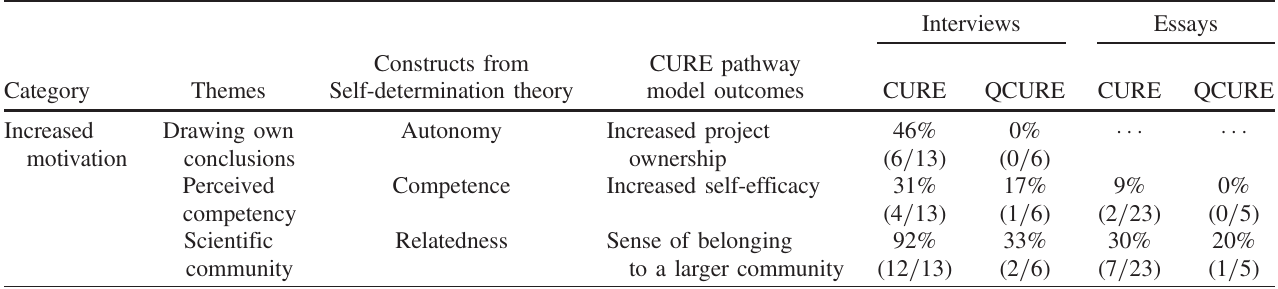
TABLE VI. Findings aligned with the CURE pathway model. Proportion of students mentioning themes, normalized to their participation in a CURE or a QCURE.